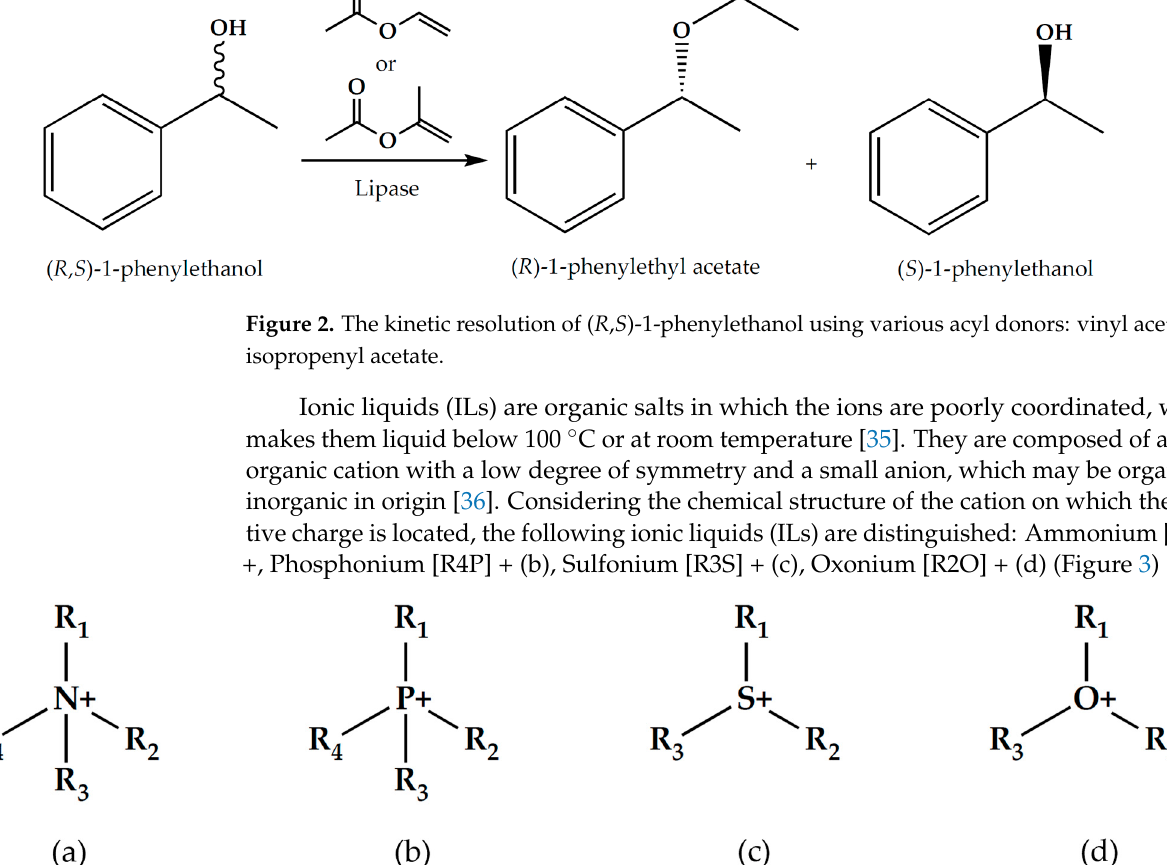
Figure 1. The structures of ( R , S )-1-phenylethanol ( a ), and enantiomers: ( R )-1-phenylethanol ( b ), and ( S )-1-phenylethanol ( c ).